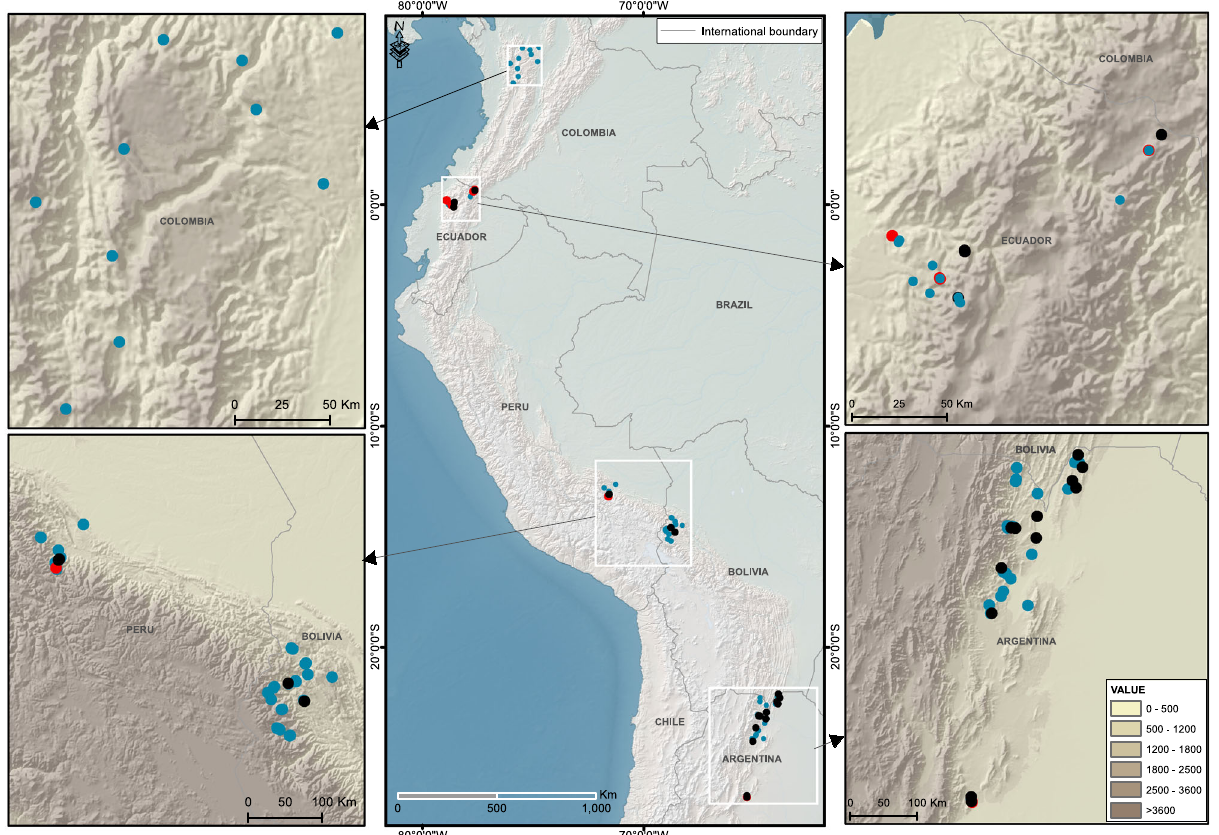
Fig. 1 Forest plots distribution in the Andean region. Distribution of the 119 forest-monitoring plots along latitudinal and elevational gradients in the subtropical and tropical Andes. The black points represent plots in which the aboveground carbon net change (AGC net change) was negative (<0 Mg ha − 1 y − 1 ). Blue points: 0 ≤ AGC net change ≤ 3 Mg ha − 1 y − 1 . Red points: AGC net change >3 Mg ha − 1 y − 1